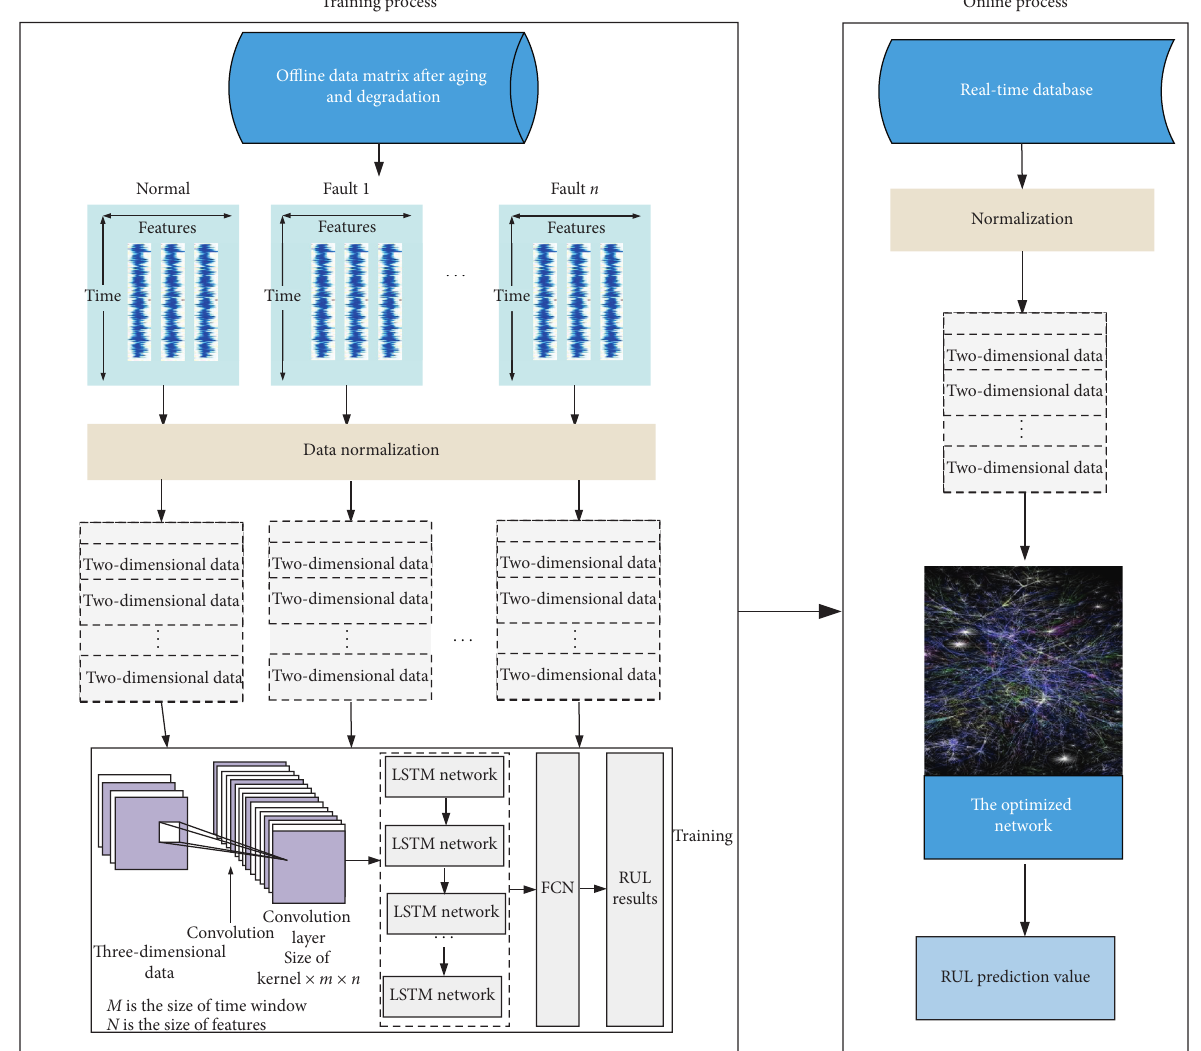
Figure 8: The flowchart of state perception and RUL